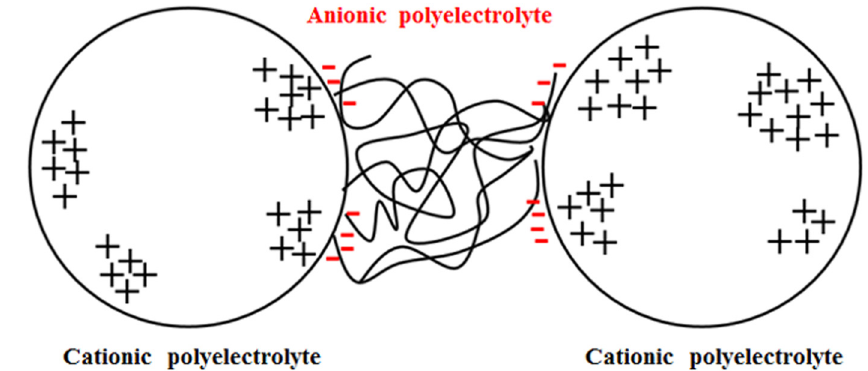
Figure 6: Reinforcement of dual retention reagent